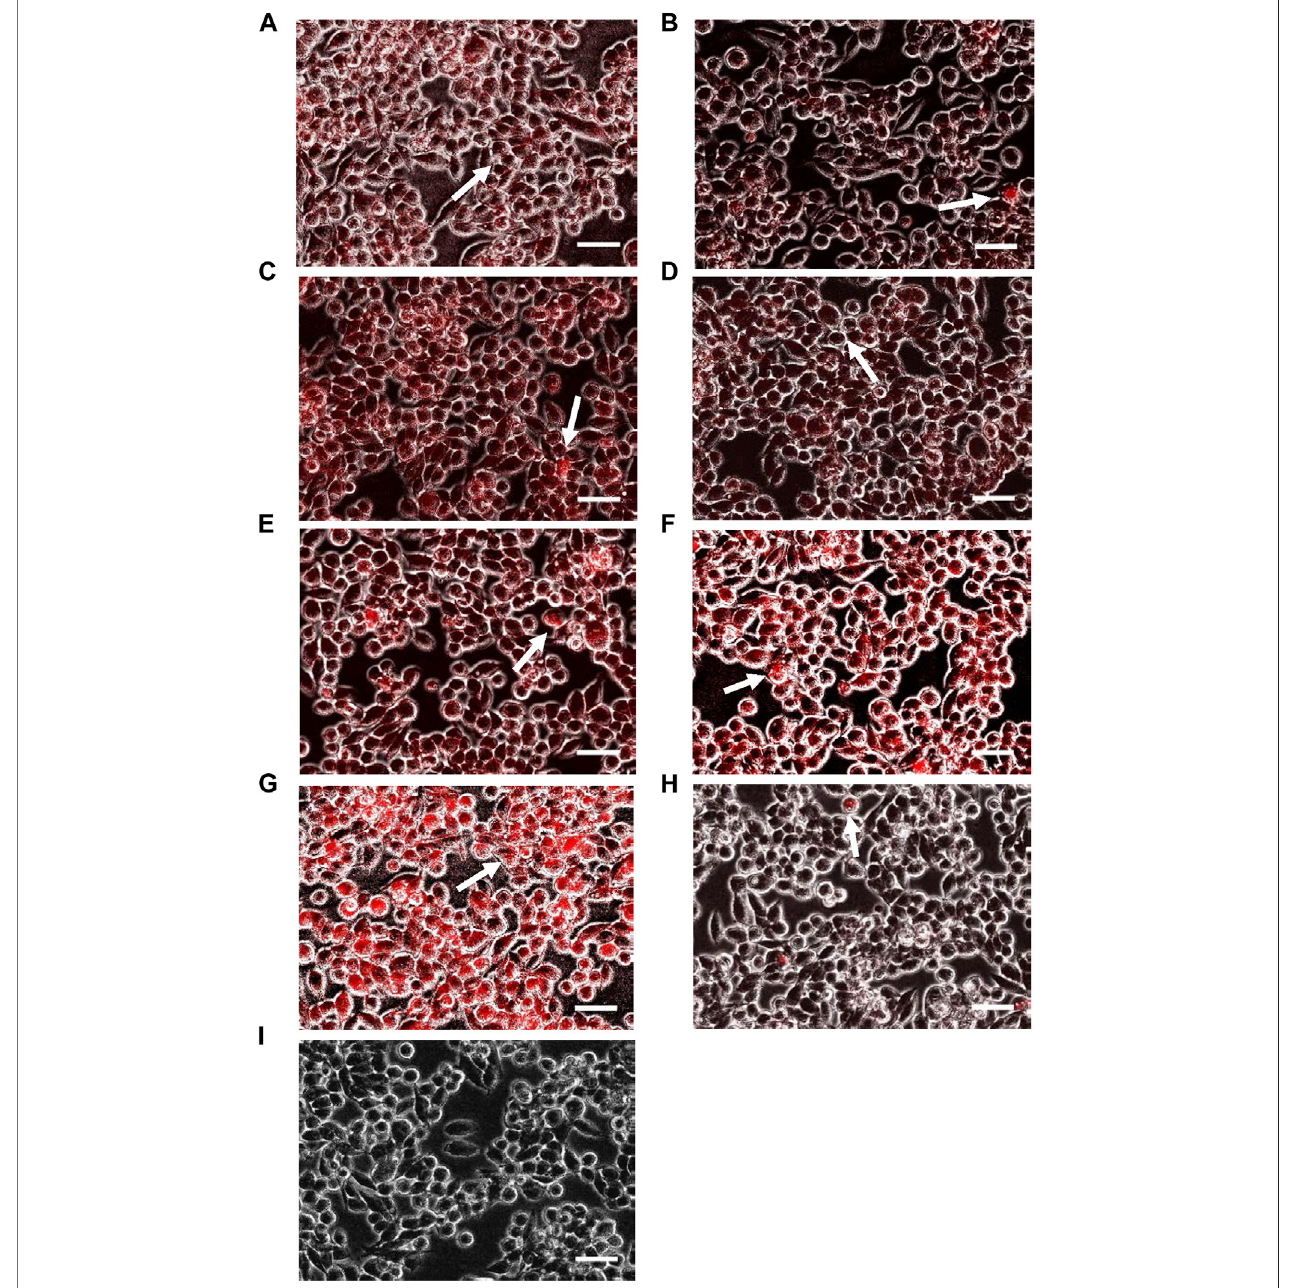
FIGURE 5 | Intracellular accumulation of doxorubicin within AD300 cells, following treatment with formulations (A) T0P0, (B) T0P1, (C) T1P0, (D) T1P1 (E) T1P2, (F) T2P1, (G) T2P2 as well as (H) doxorubicin solution and (I) no treatment (as control groups). Arrows represents accumulation of doxorubicin in the nucleus (magni fi cation: × 10, scale bar: 10 µm).